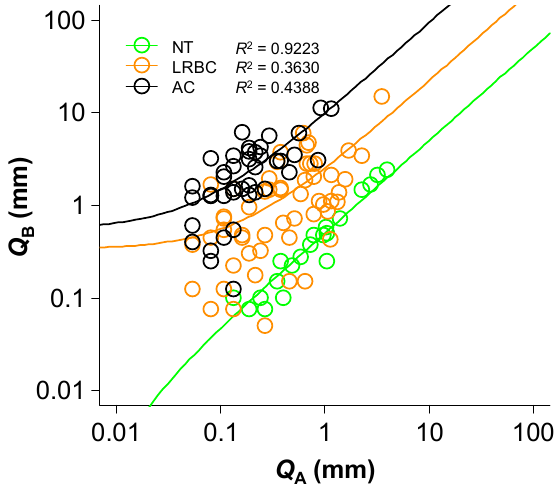
Figure 9. Surface runoff in plot B vs. surface runoff in plot A.